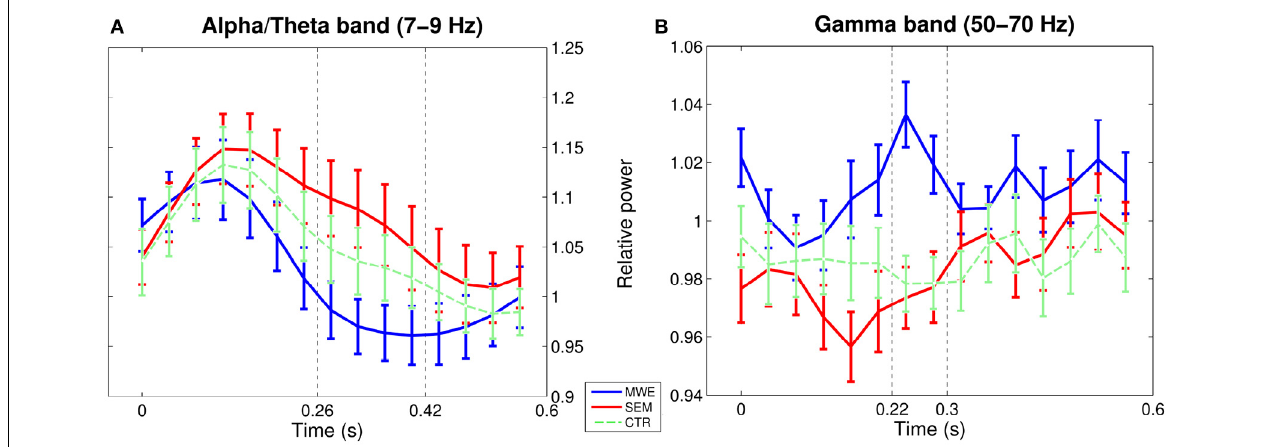
FIGURE 2 | Temporal evolution of power between 0 and 0.6s post TW onset over selected channel-frequency windows: (A) alpha/theta, (B) mid gamma band. Error bars indicate standard errors around the mean, for